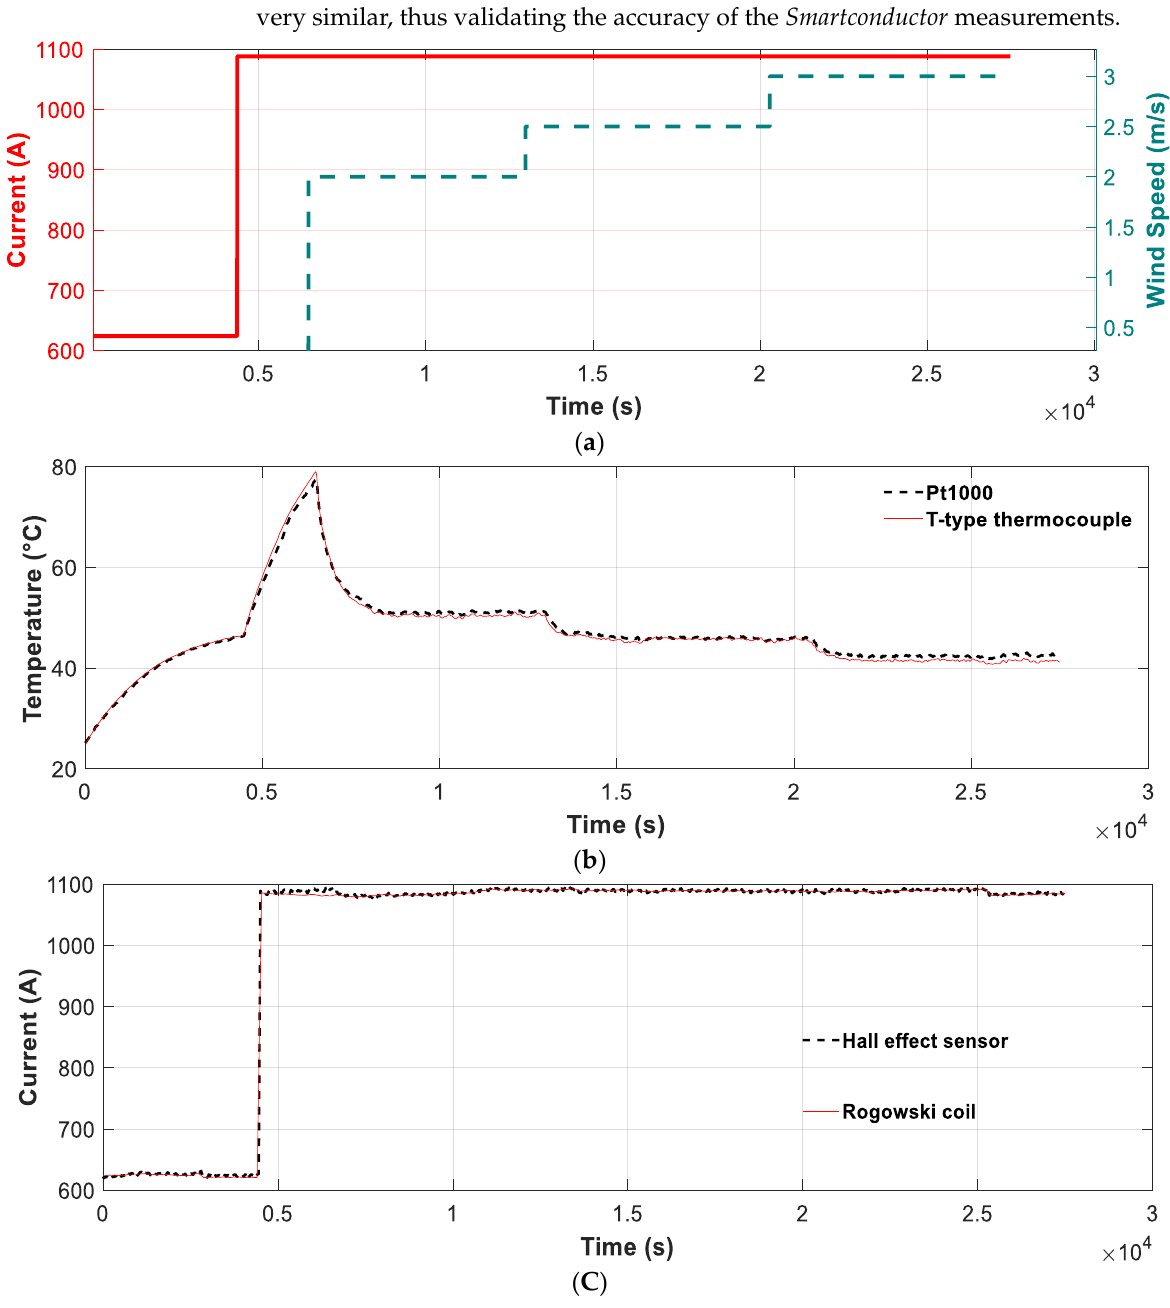
Figure 5. ( a ) Planned current intensity and perpendicular wind speed profiles during the test. ( b ) Conductor temperature measured by the Pt1000 sensor ( Smartconductor ) and the T-type thermocouple. ( c ) Currents measured by the Hall effect sensor ( Smartconductor ) and the Rogowski coil.